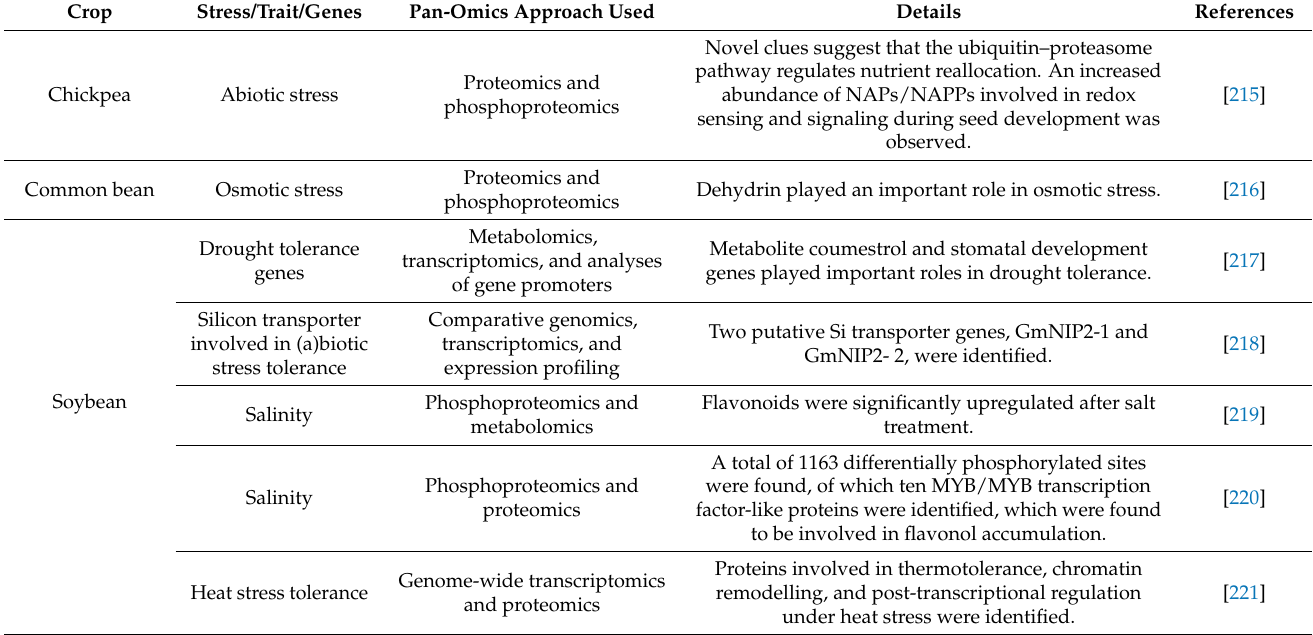
Table 8. Multi-omics integration for improved abiotic stress tolerance in pulse